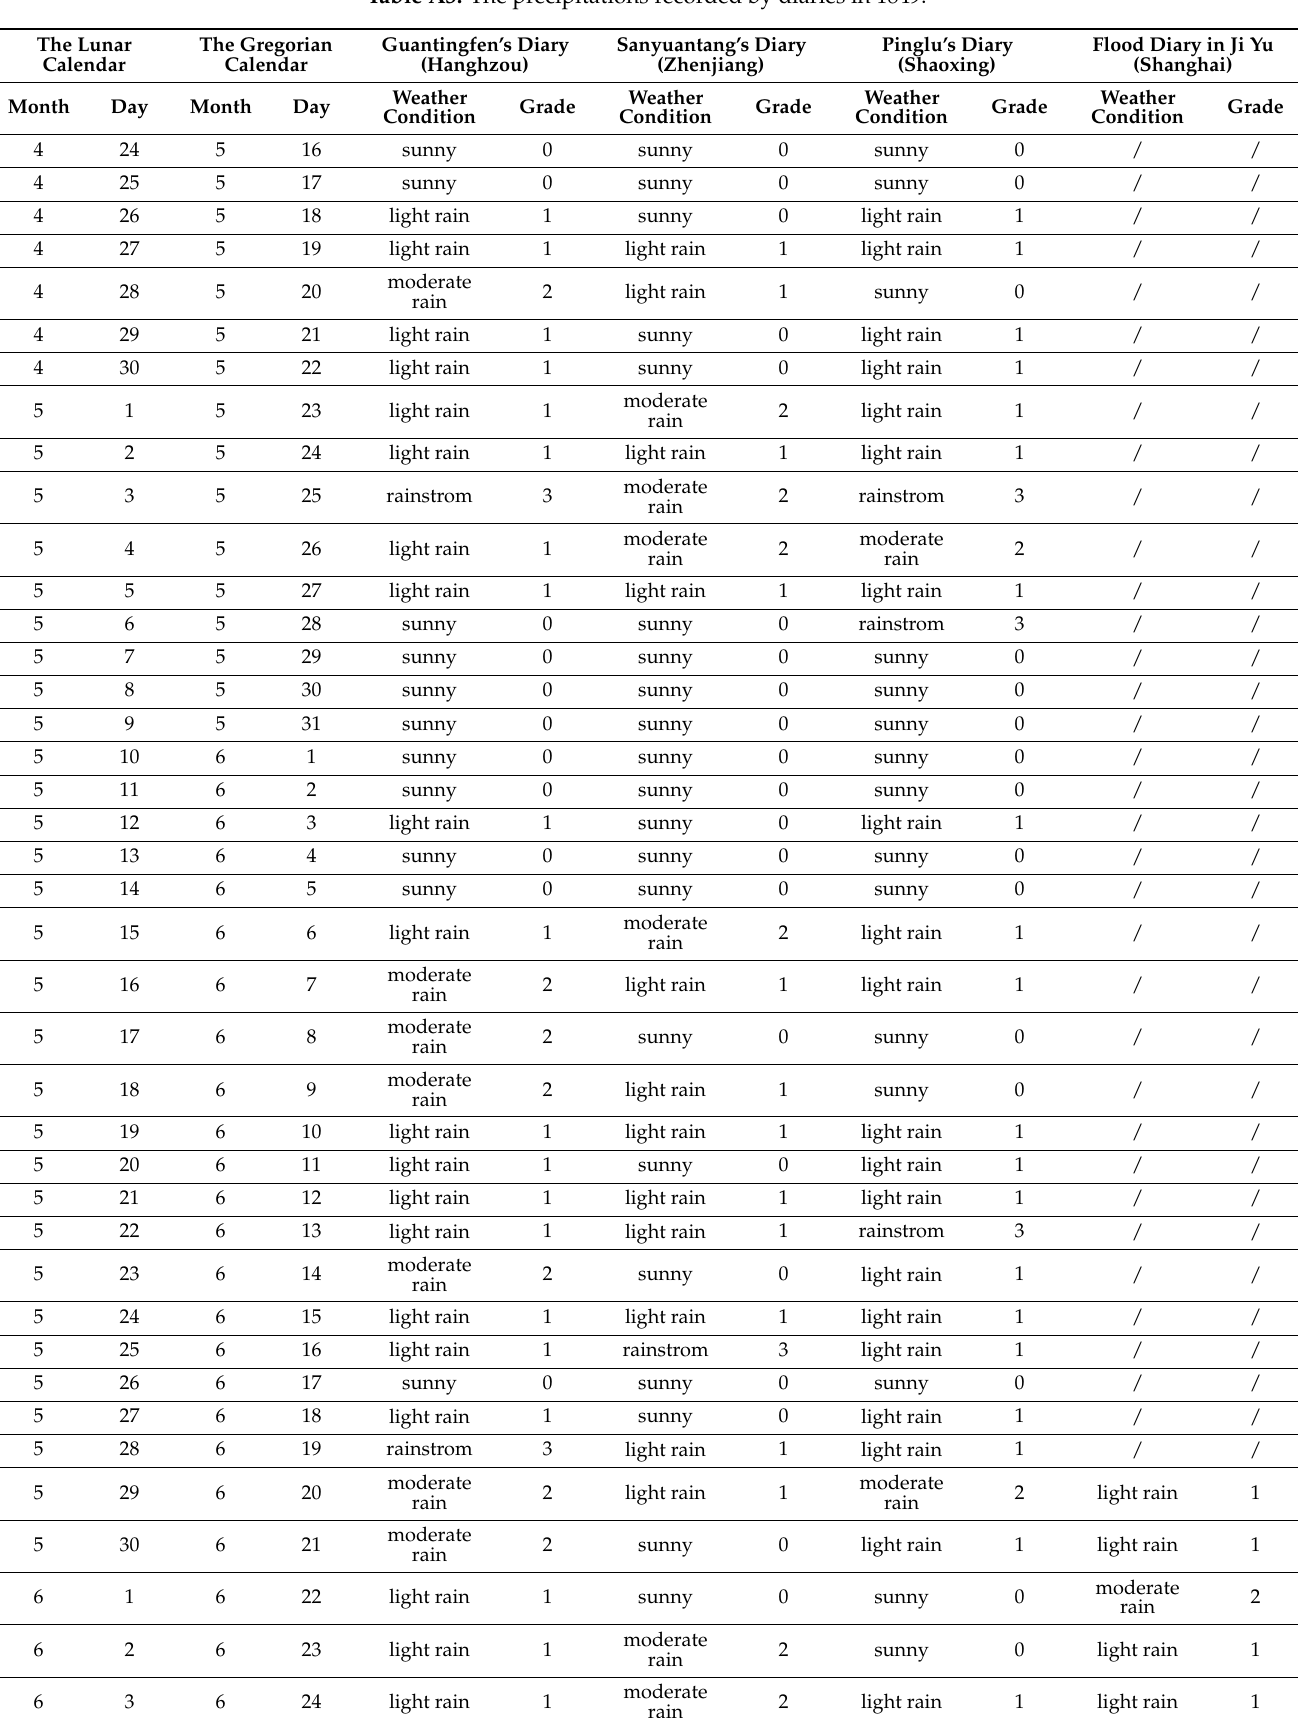
Table A3. The precipitations recorded by diaries in